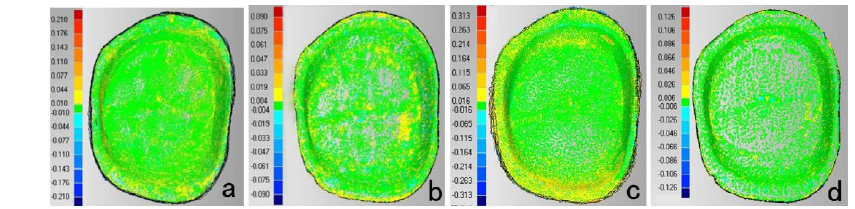
Figure 1. Color-coded difference images showed the precision of each scanner. ( a ) TRIOS ( b ) D700 ( c ) MHT ( d ) inEos (Buccal surface is on the top; Mesial surface is on the